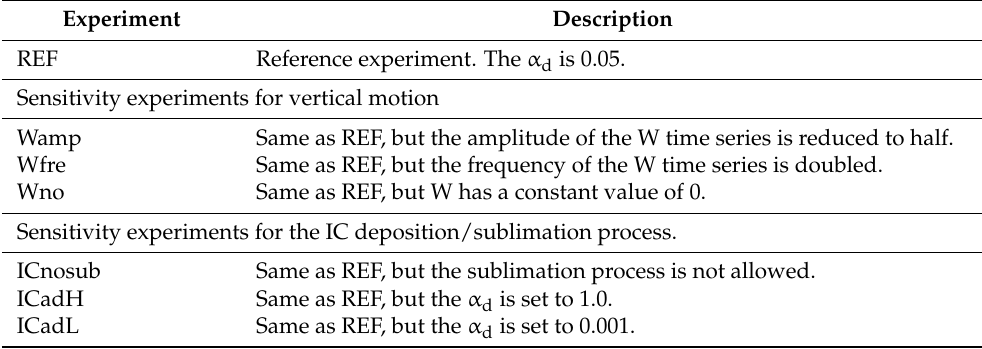
Table 1. The experiments carried out in this study. Experiment